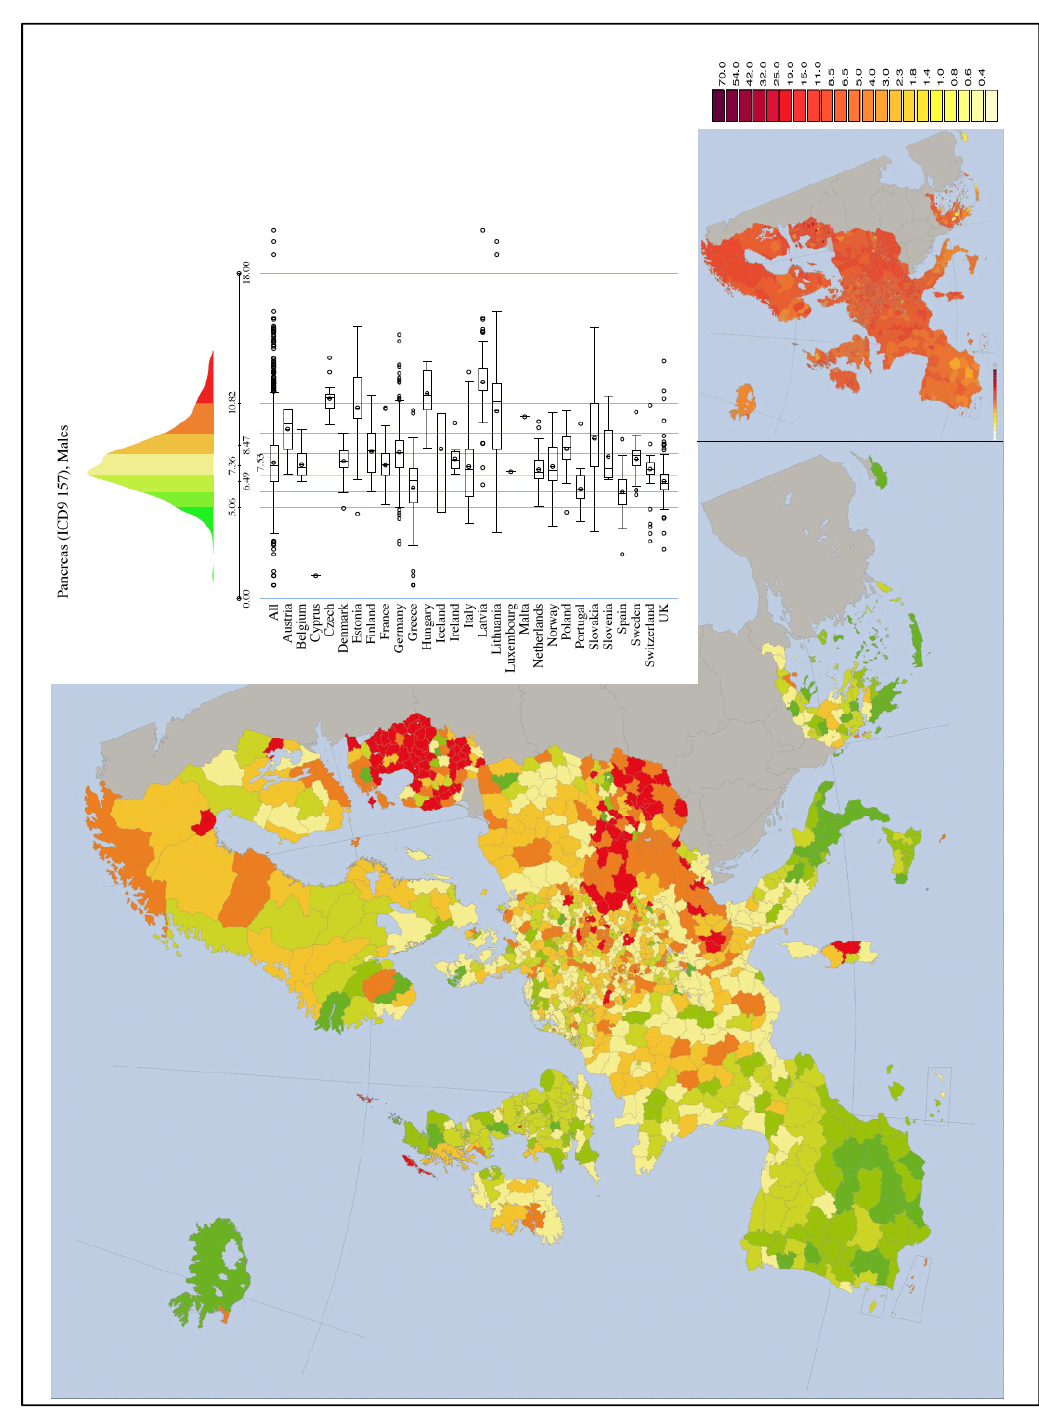
Figure 9. PC mortality (Males) map in Europe from IARC (1993–1997)